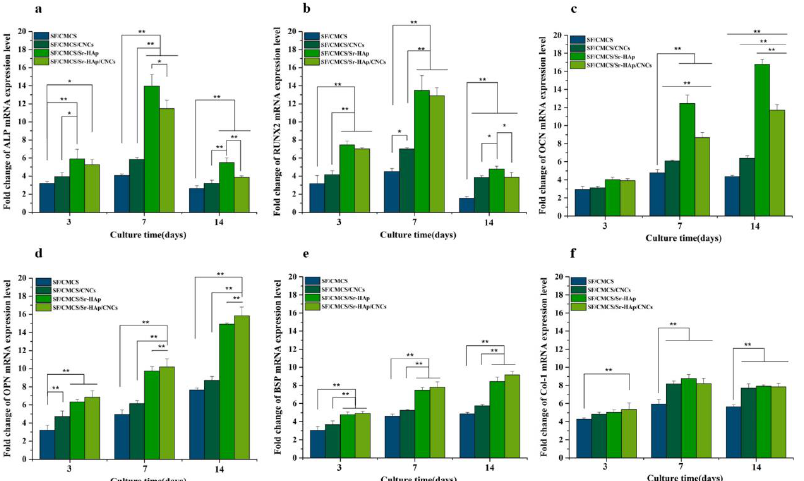
Figure 7. Osteogenesis gene expression of the SF-based scaffolds SF/CMCS, SF/CMCS/CNCs, SF/CMCS/Sr-Hap, and SF/CMCS/Sr-HAp/CNCs: ( a ) ALP, ( b ) RUNX2, ( c ) OCN, ( d ) OPN, ( e ) BSP, ( f ) COL-1. Probability (p) value of b0.05(*) is considered as significant and (p) value of b0.01(**) is considered to be highly significant. Copyright © [215] 2019 Elsevier B.V. The improvement in compressive strength makes it an attractive candidate for bone defect repair at the same time. Because of its porosity, gel-forming characteristics, simplic- ity of chemical manipulation, and high affinity for in vivo macromolecules, CMCS will be a viable contender as a supporting material for BTE [217].